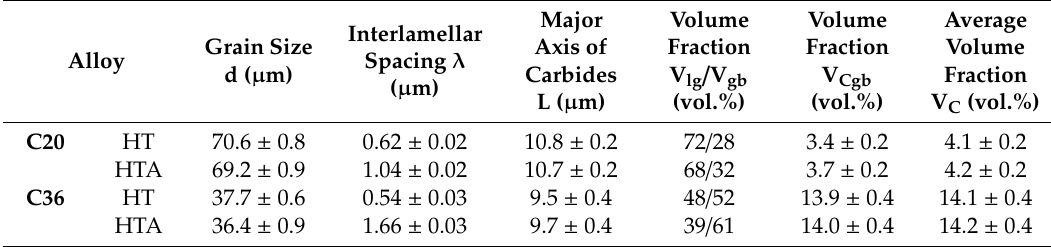
Figure 5. Measured grain size and interlamellar spacing in C20 and C36 alloys after heat treatment and heat treatment combined with ageing: ( a ) The typical log-normal distribution curves of grain size; ( b ) The typical log-normal distribution curves of α 2 - α 2 interlamellar spacing. The types of distribution curves are marked in the figures. Table 3. Measured microstructural parameters of C20 and C36 alloys after heat treatment and heat treatment combined with